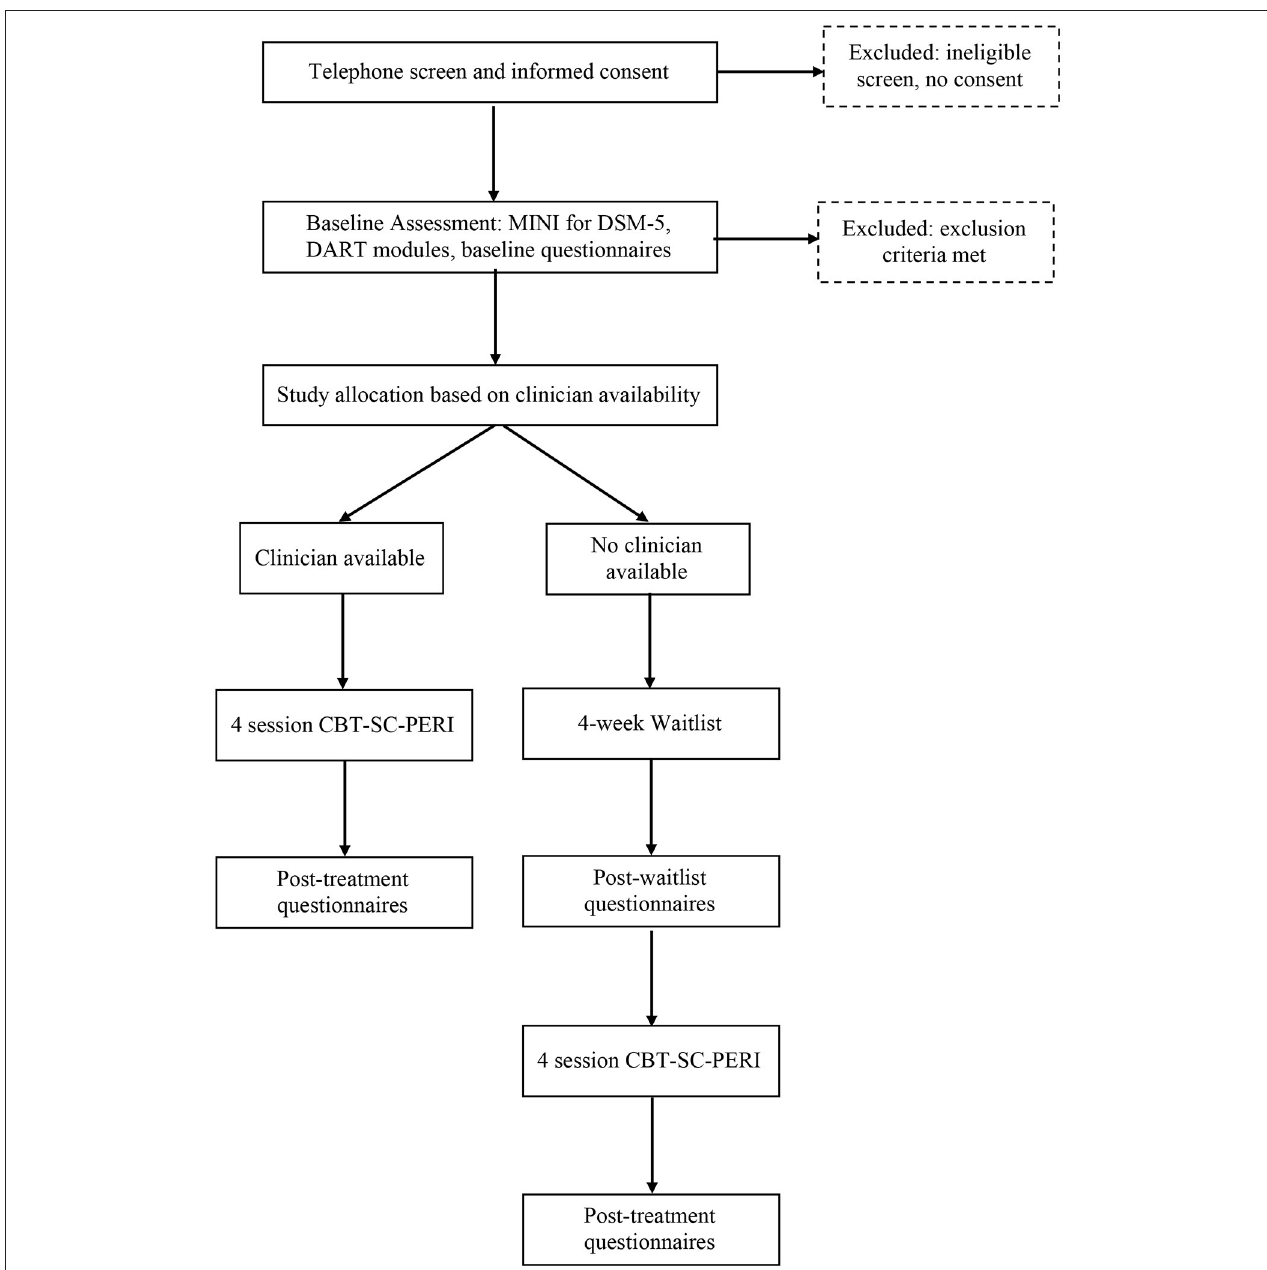
FIGURE 1 | Flowchart of trial